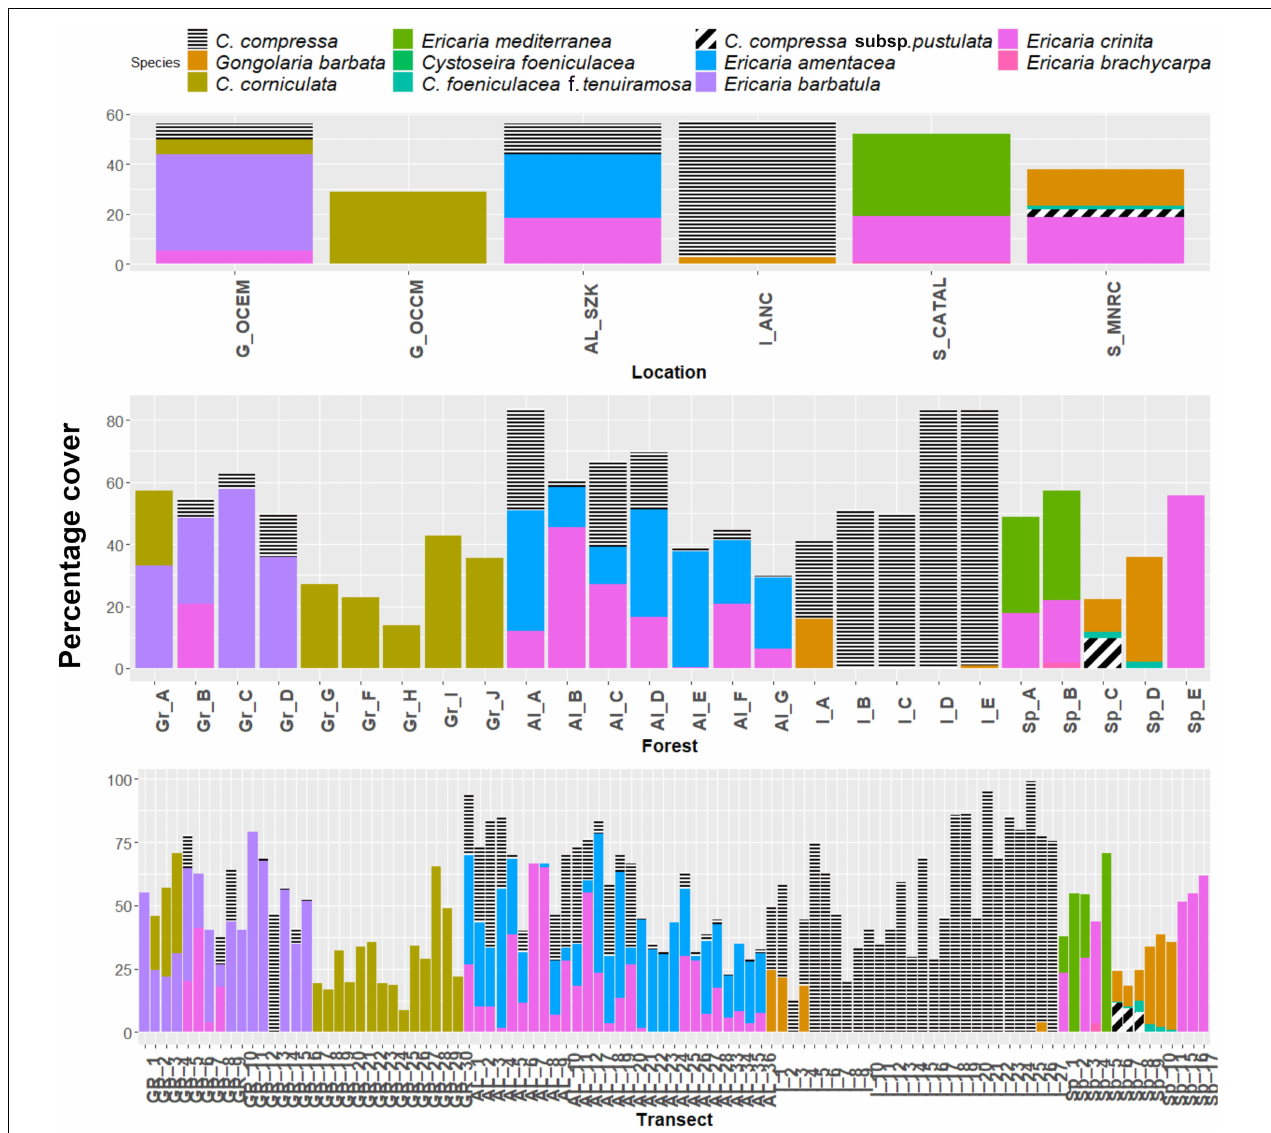
FIGURE 3 | Mean percentage cover of eleven fucalean brown seaweed species at the three different spatial scales (transect, meadow, and location) studied. In comparison, the perennial fucalean are indicated by colour columns, the semi-perennials by black and